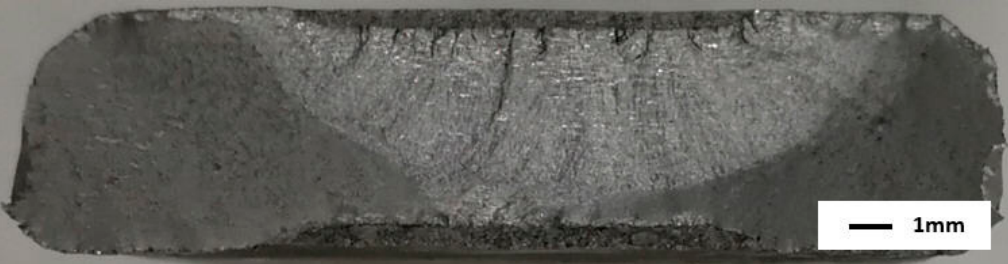
Figure 18. Failure surface associated with specimen 7075HT_F_1, failed at 36,284 cycles.